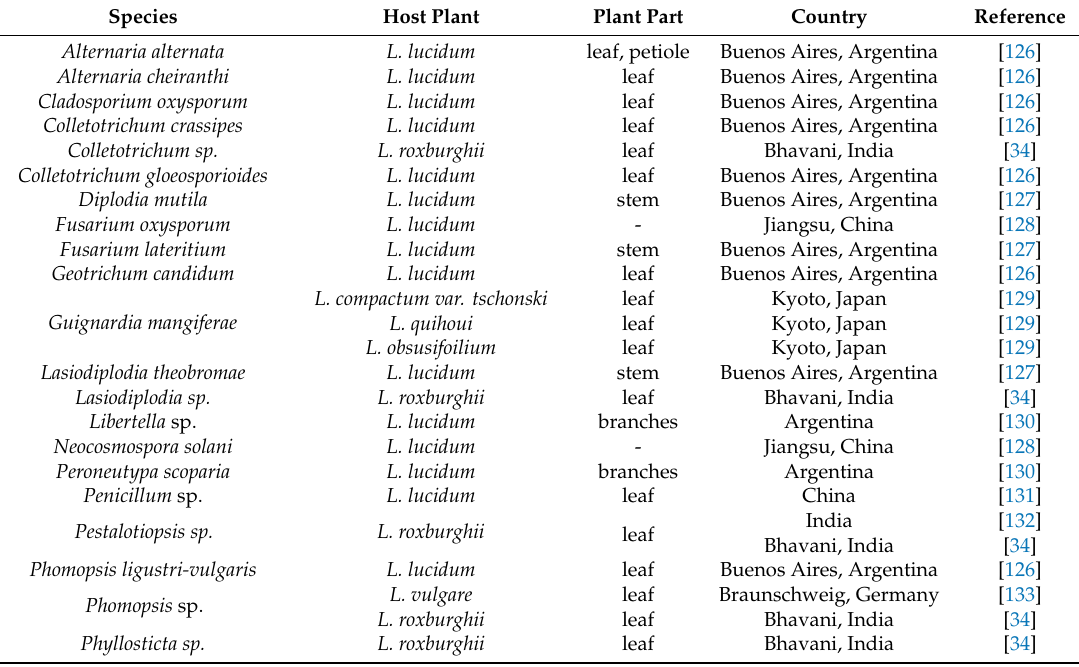
Table 11. Endophytic fungi isolated from Ligustrum